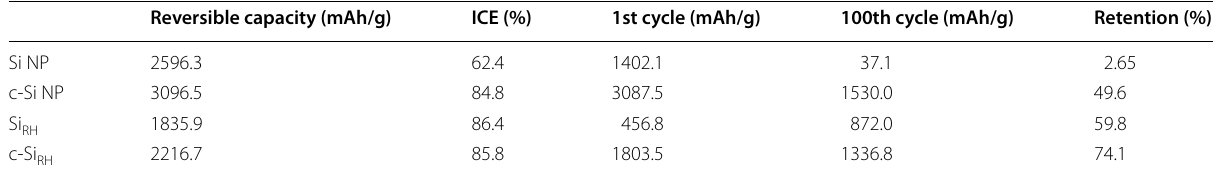
Table 1 Electrochemical data of four different Si electrodes Reversible capacity